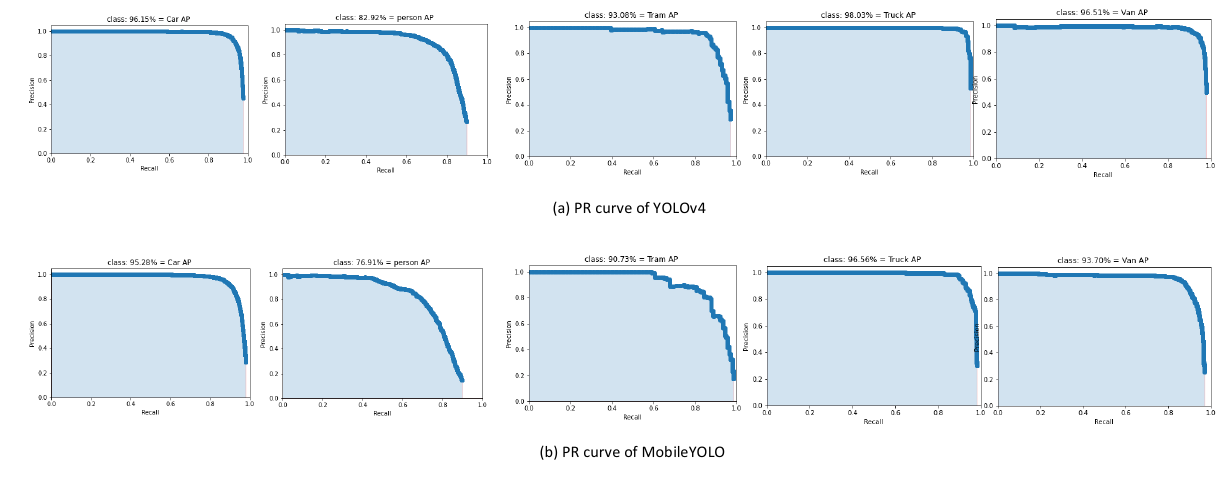
Figure 8. The P–R curves of the detection results.